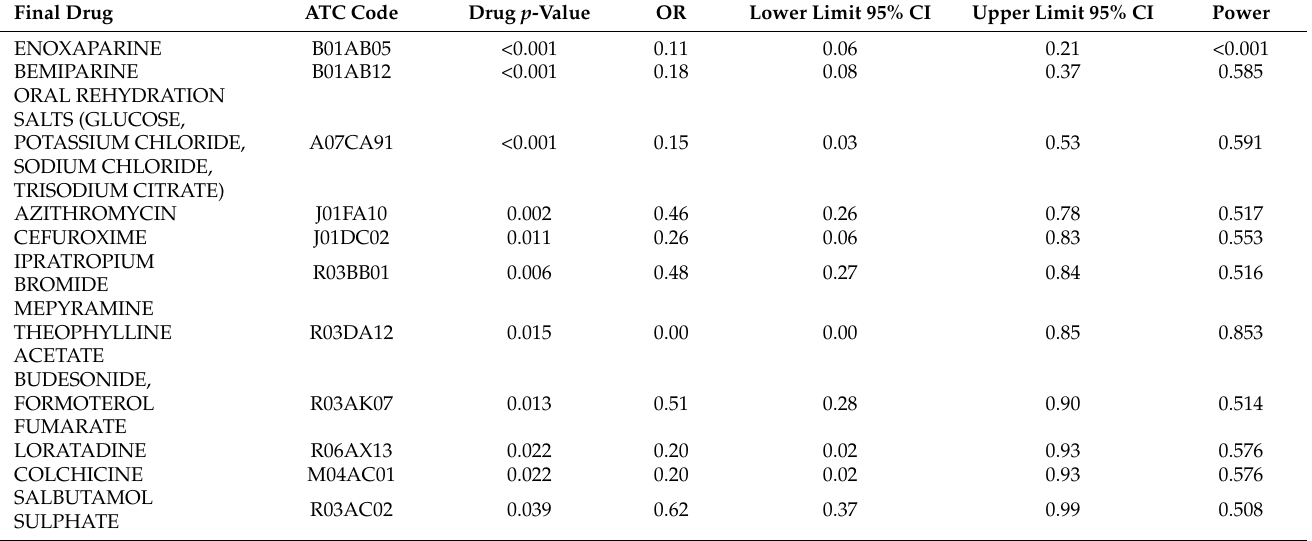
Table 2. Final drug PSM analysis. Lower and upper limits of the 95% confidence interval for the odds ratio. The final substances significantly associated with